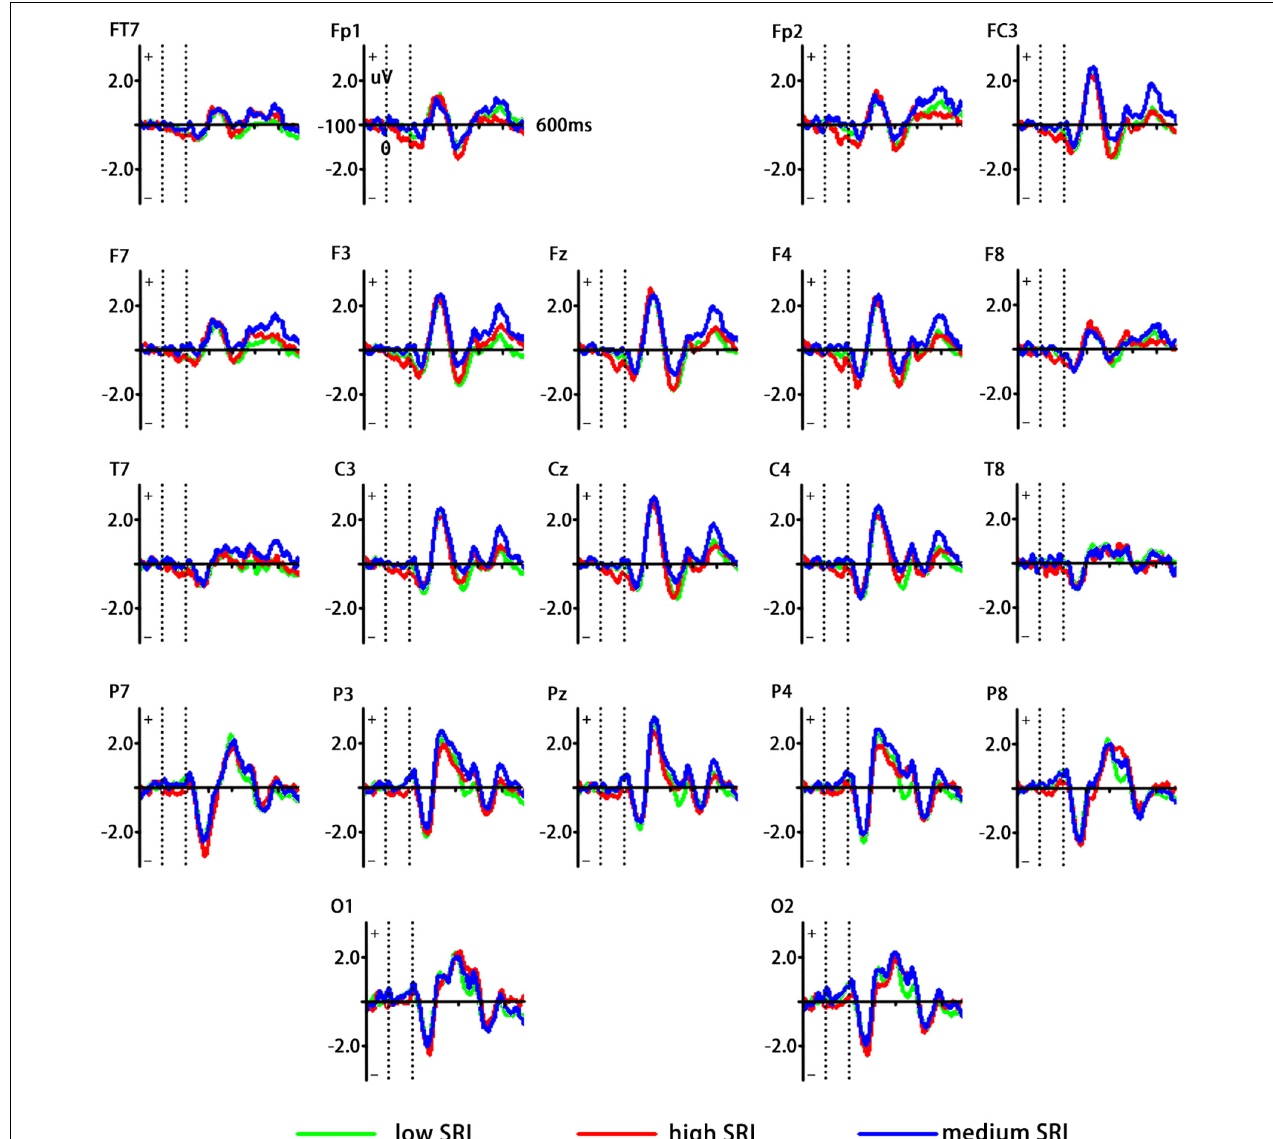
FIGURE 2 | Grand averaged event-related potentials (ERPs) waveforms elicited by the standard [low self-related information (SRI)] and the deviant (high and medium SRI) stimuli, respectively. Green curve represents low SRI; red curve represents high SRI; and blue curve represents medium SRI.